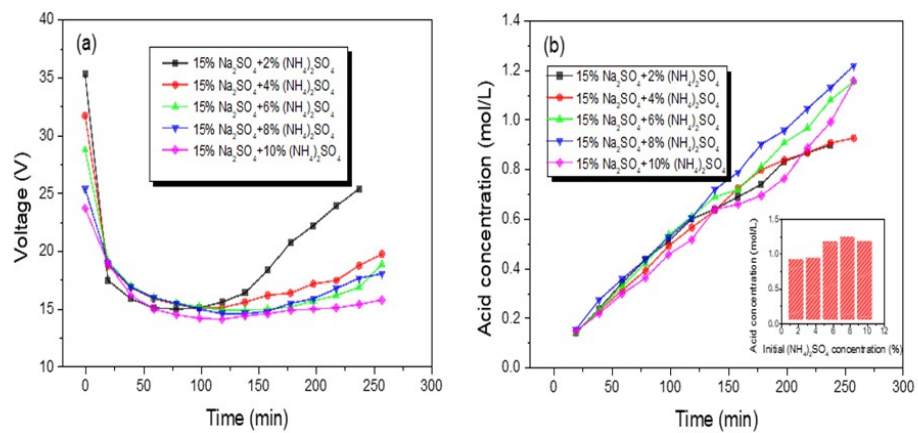
Figure 6. The voltage–time curves ( a ), the acid concentration–time curves ( b ) in the BMED process with different mass fractions of (NH 4 ) 2 SO 4 and the acid concentration-initial (NH 4 ) 2 SO 4 concentration relationship.